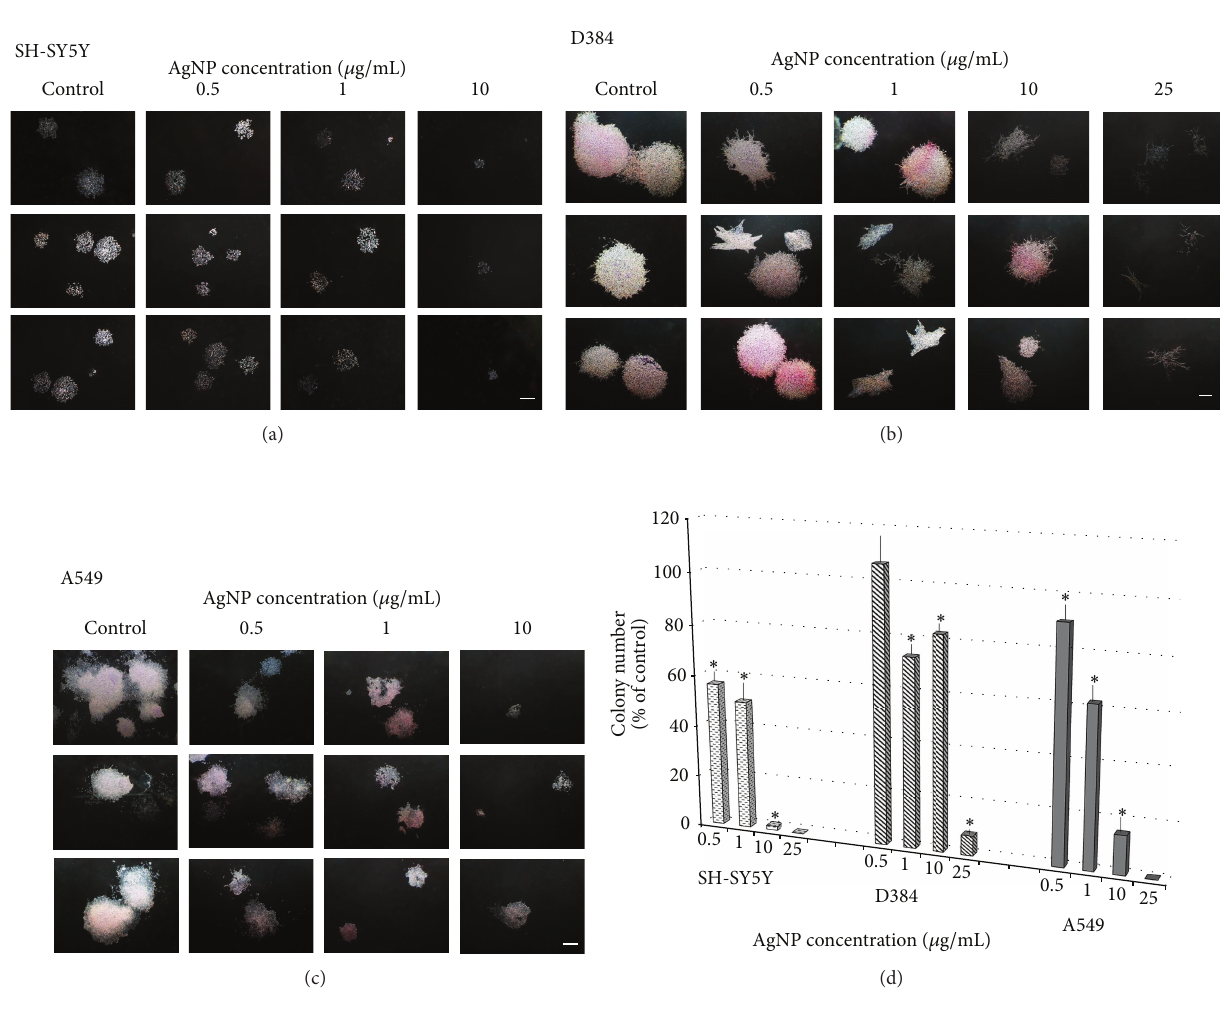
Figure 4: Clonogenic assay up to 10-day exposure. The images of randomly selected microscopic fields show the colonies of SH-SY5Y (a), D384 (b), and A549 (c) cells formed after 7 or 10 consecutive days of exposure to increasing concentration of AgNPs (0.5–25 𝜇 g/mL). The colonies of all cell types treated with AgNPs showed dose-dependent reductions on size, colony number, and changes in colony morphology compared to each respective control (scale bar is 600 𝜇 m). Panel (d) shows a semiquantitative analysis in SH-SY5Y, D384, and A549 cell lines: histograms display the number of colonies formed after 7 or 10 consecutive days of exposure to increasing concentration of AgNPs (0.5–25 𝜇 g/mL). Dose-dependent inhibition of colony formation from all cell models was observed, in particular cell sensitivity was SH- SY5Y > A549 > D384. Decrease in SH-SY5Y and D384 colony number was 50% and 25%, respectively, at 1 𝜇 g/mL, and exposure to even lower AgNP dose, such as 0.5 𝜇 g/mL, was significantly effective towards SH-SY5Y and pulmonary cells. Data are expressed as percentage of respective control colonies. Error bars are ± S.D. ∗ Significant decrease of colony number: different from control ( 𝑃 < 0.05 ), statistical analysis by ANOVA followed by Tukey’s